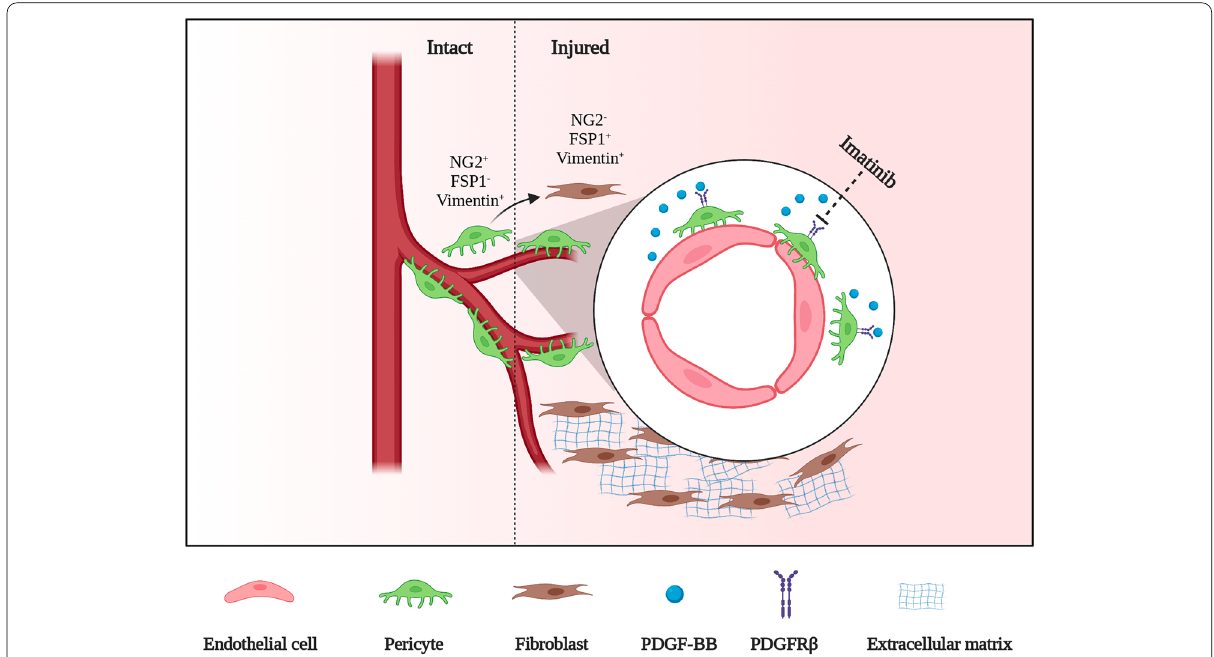
Fig. 9 Microvascular endothelial cells secrete PDGF‑BB to induce PDGFRβ + pericyte detachment from the blood vessel wall and then transition into fibroblasts, which contributes to the formation of fibrotic scar. The pharmacologic PDGFRβ inhibitor imatinib restrains pericyte‑fibroblast transition and fibrotic scar